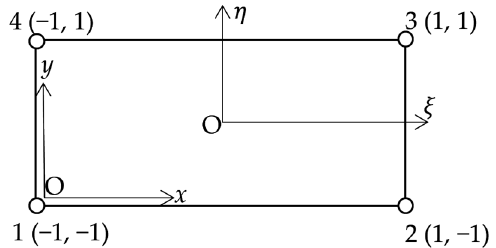
Figure 4. Notation and non-dimensional coordinates of rectangular finite element.